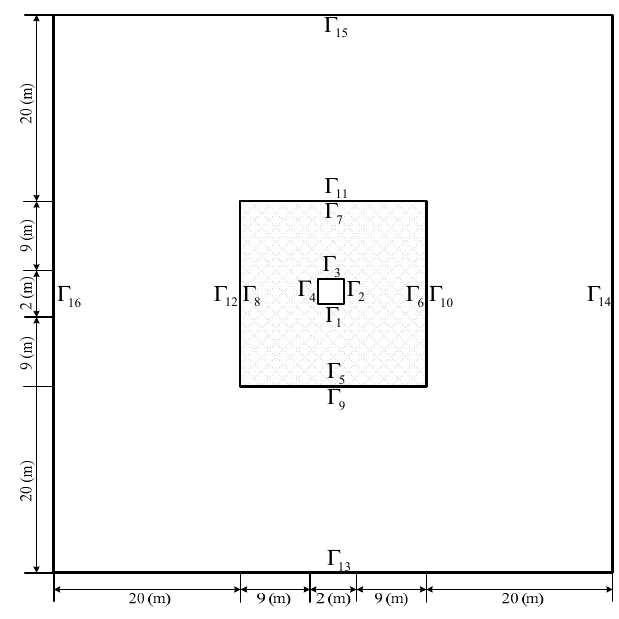
Figure 15. The configuration of the boundary condition.